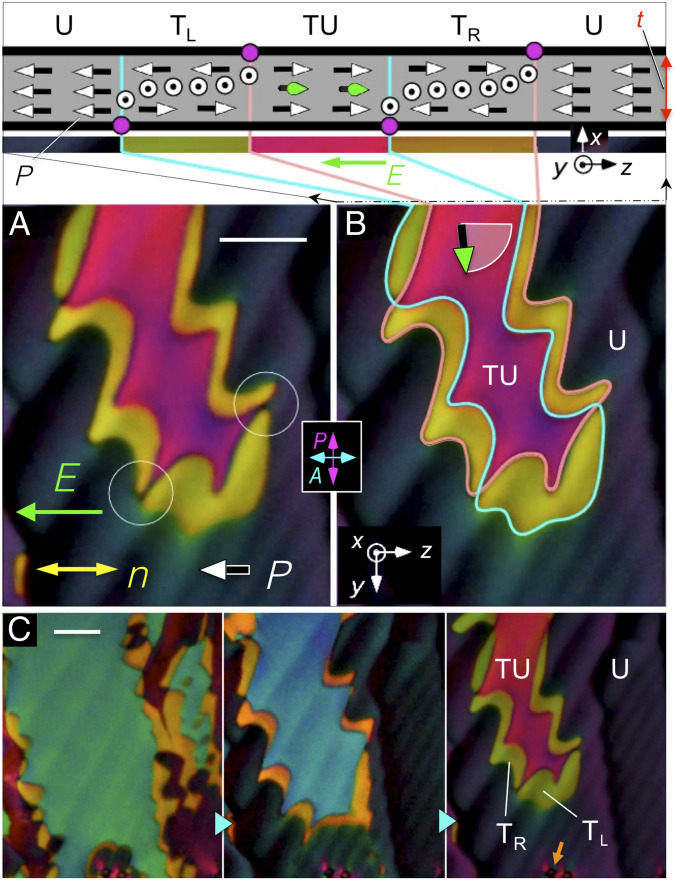
DTLM images of a large, twisted domain with surface polarization pointing to the right, surrounded by a uniform region with surface and bulk polarization pointing to the left, in the direction of an applied field. (A) Twisted domain (magenta) and structural elements P, n, and E. (B) The section drawing shows the two-dimensional structure of the cell in the x, z plane along the top edge of the image: the uniform (U), field-preferred state of the background; the surface orientations reversing at the boundaries of the central domain; P in the twisted–untwisted (TU) state in the center of the domain, with the orientation in the middle of the cell indicated by green vectors, and the intermediate left- and right-handed twisted states TL and TR (olive and gold). π surface disclination lines (magenta dots) mediate polarization reorientation at the top (pink line) and bottom (cyan line) cell plates. Where the surface disclination lines overlap, the director is uniformly oriented along y through the thickness of the cell, giving extinction between the crossed polarizers (dark spots circled in A). In the absence of applied field, the left and right surface polarization states are energetically equivalent. (C) The central domain shrinks with increasing E field. The birefringence color changes from green to blue to pink as the rotation of P in the middle of the cell increases. T = 120 °C. t = 11 µm. Silica spheres (orange arrow) for visual size reference in the bottom of C have an apparent diameter of 4 µm (See SI Appendix, Fig. S10). (Scale bars, 35 µm.)